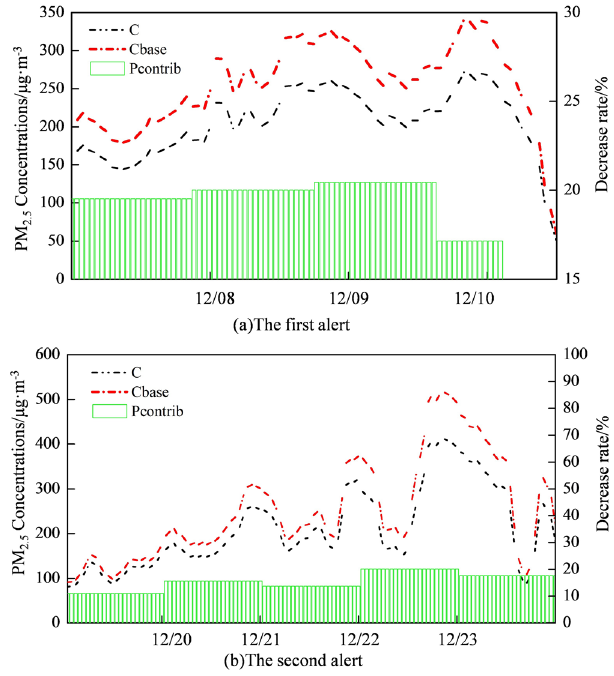
Figure 5. Effects of emission reduction measures on PM 2.5 concentrations during two red alerts ( P contrib , C and C base are the contribution rate of emission reduction to PM 2.5 concentrations, the simulated PM 2.5 concentration under the emission reduction scenario and simulated PM 2.5 concentration in baseline scenario respectively).